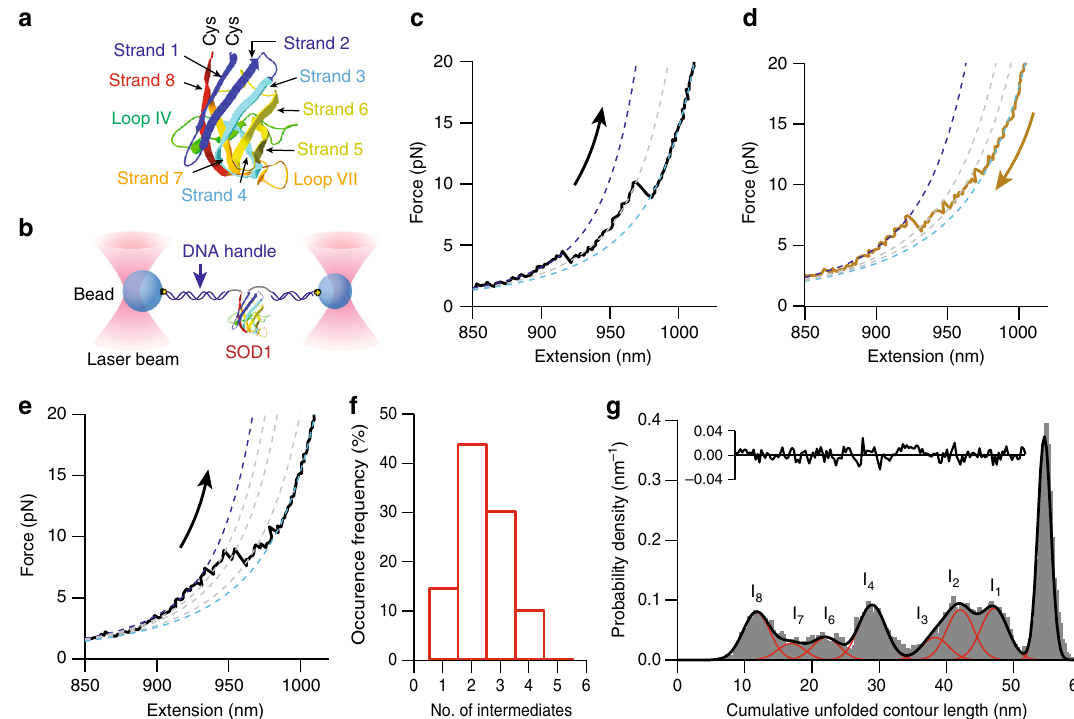
Fig. 1 Force spectroscopy of SOD1. a The structure of the apo-SOD1 monomer, showing the 8 β -strands and two functional loops (PDB ID: 3ECU). Cys residues engineered at the termini were used for attaching DNA handles. b Schematic of the force spectroscopy assay. The SOD1 monomer was attached covalently to DNA handles linked to polystyrene beads held by laser beams. c An unfolding FEC of the SOD1 monomer showing an intermediate state. Dashed lines: WLC fi ts to the folded (blue), intermediate (gray), and unfolded (cyan) states. d A refolding FEC showing two intermediate states. e An unfolding FEC with three intermediate states. f The distribution of the number of intermediate states observed in unfolding FECs. g The distribution of the cumulative contour length of unfolded protein at each state observed in the unfolding FECs, as measured from the natively folded state via WLC fi ts. The positions of seven intermediate states were identi fi ed by Gaussian fi ts (red) of the peaks in the